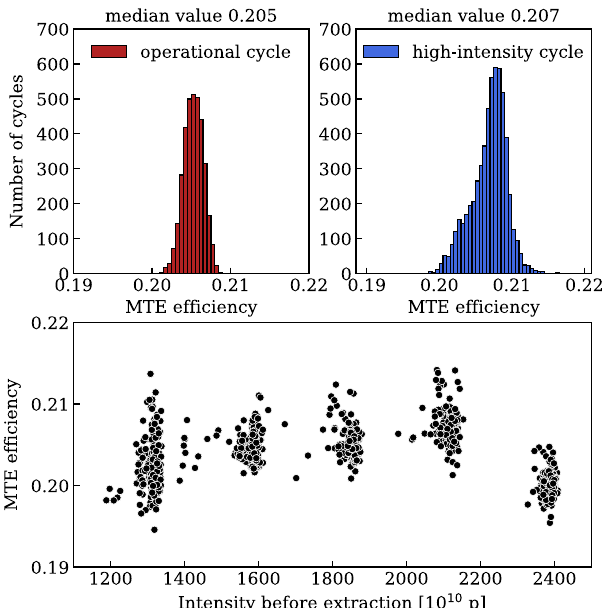
FIG. 11. Measured extraction beam losses for the islands (upper) and core (lower) as a function of the total beam intensity. The losses are measured in the extraction region, i.e., at the location of the dummy septum in SS15 and of the magnetic septum in SS16. The straight lines best fitting the data are also